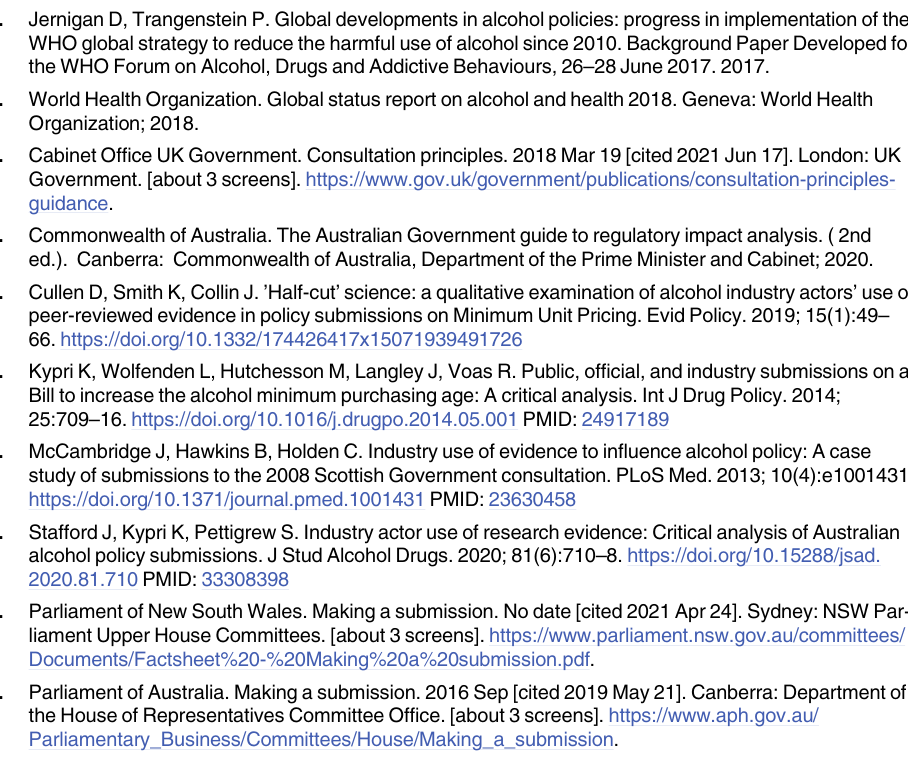
S2 Table. Accessibility of cited evidence by actor group, consultation and publication